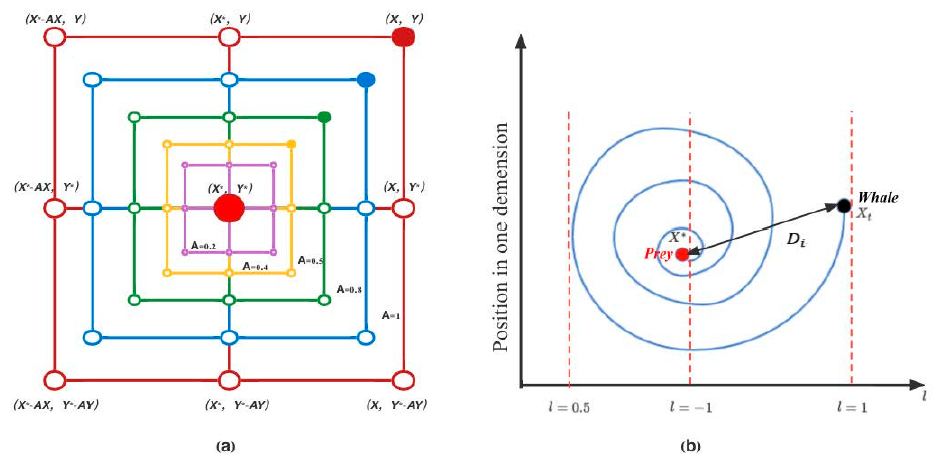
Figure 3. Bubble-net search mechanism implemented in WOA. ( (cid:1850) ∗ represents the best solution obtained so far): ( a ) shrinking encircling mechanism; ( b ) spiral updating position. obtained so far): ( a ) shrinking encircling mechanism; ( b ) spiral updating